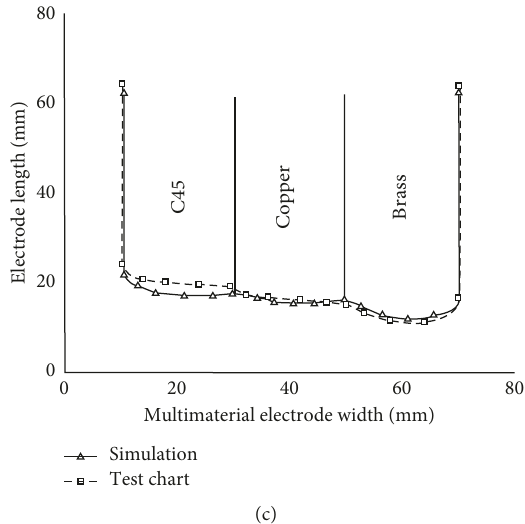
Figure 11: Comparison of the simulation and experimental results of C45-copper-brass multimaterial electrodes. (a) C45-copper- brass simulation results. (b) C45-copper-brass experimental results. (c) Simulation extraction curve and experimental identification